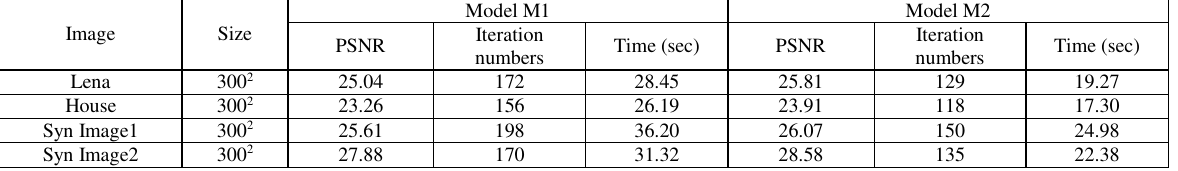
taken in seconds. Model